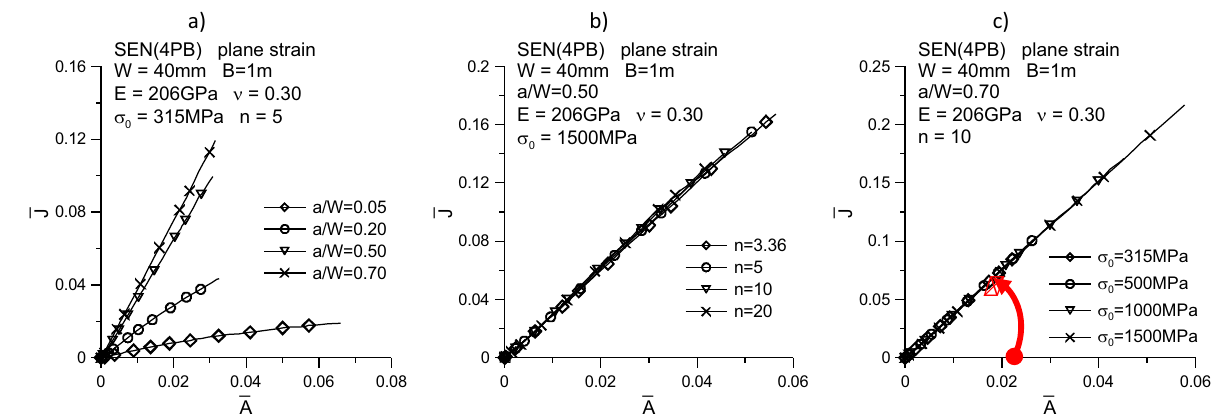
Figure 16: The in fl uence of the relative crack length a / W ( a ) , strain hardening exponent n ( b ) , and yield stress σ 0 ( c ) on the estimated J f A ¯ ¯ ( ) = trajectories for SEN ( 4PB ) specimens ( based on ref. [ 13 ]) . The η coe ffi cient is equal to the tangent of the angel φ ( the slope of the curve J f A ¯ ¯ ( ) = to the abscissae )